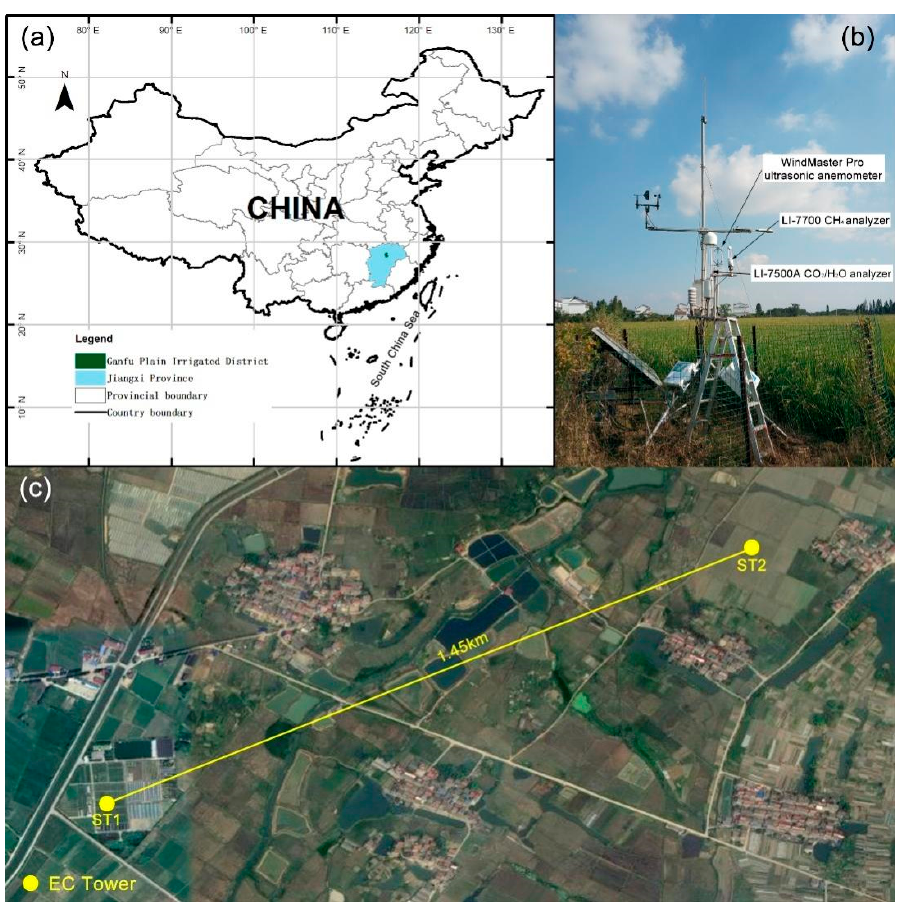
Figure 1. Location of Ganfu Plain. ( a ) Sketch map of the station location; ( b ) Setup of the eddy covariance system at ST2 with a WindMaster Pro ultrasonic anemometer, LI7500A open-path CO 2 /H 2 O analyzer, and LI-7700 open-path CH 4 analyzer; ( c ) Google Earth map of ST1 and ST2 (the yellow circles indicate the position of the eddy covariance towers).